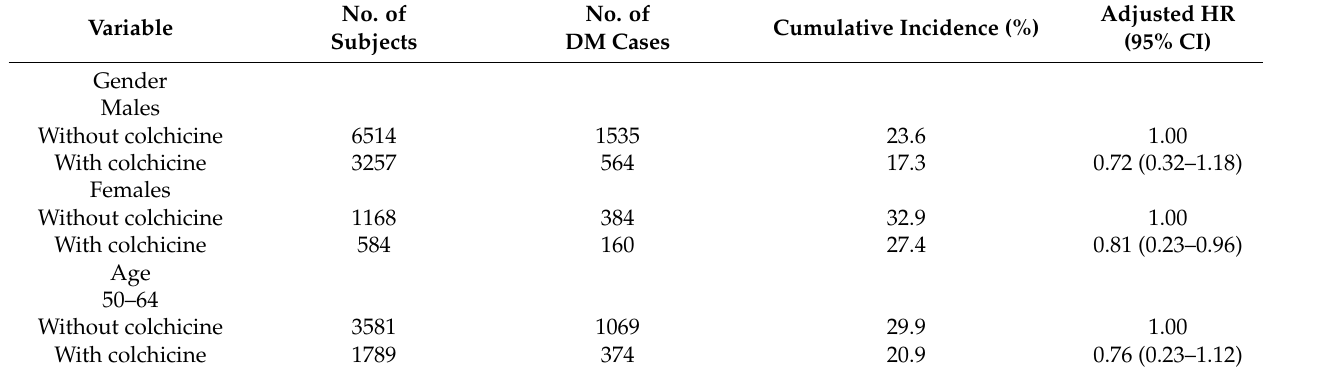
Table 3. Association between colchicine administration and risk of type 2 diabetes mellitus stratified by sex and